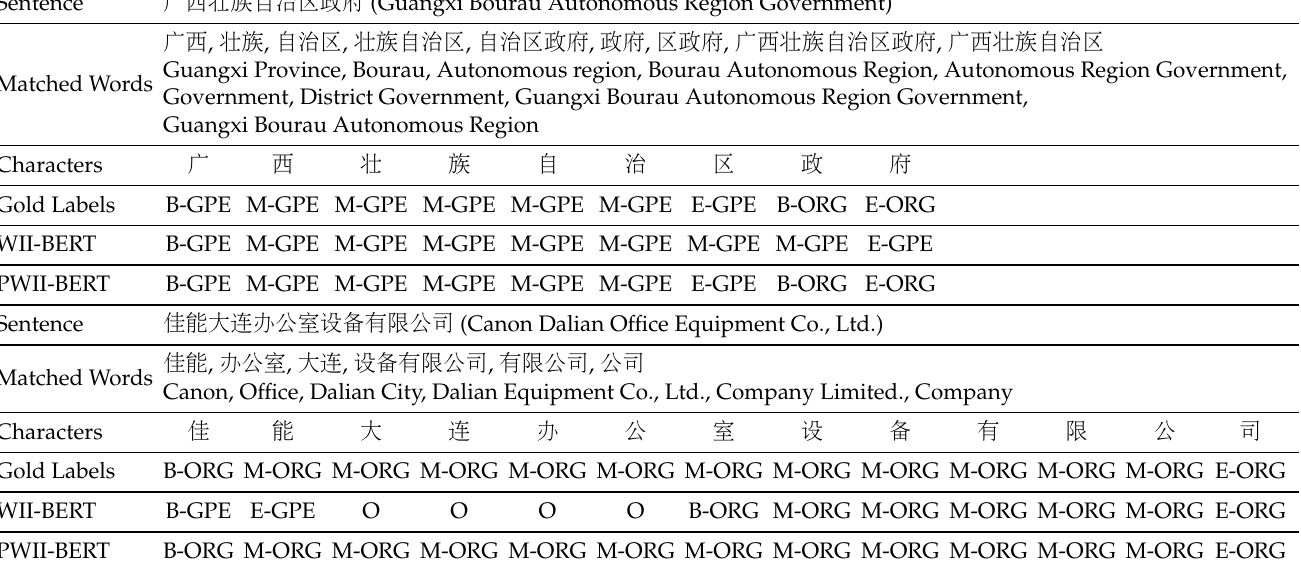
Table 9. Case study of the proposed method. WII-BERT denotes using the original Transformer structure before and after